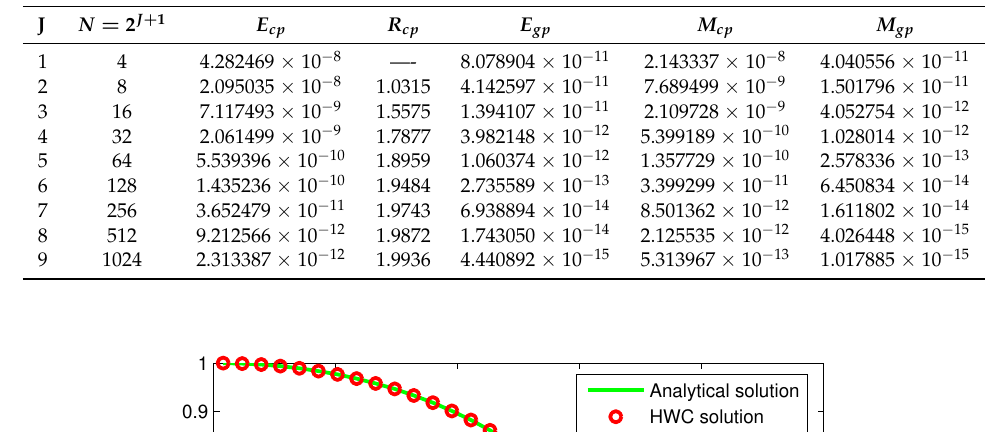
Table 4. E cp , R cp , E gp , M cp and M gp for Problem 3.